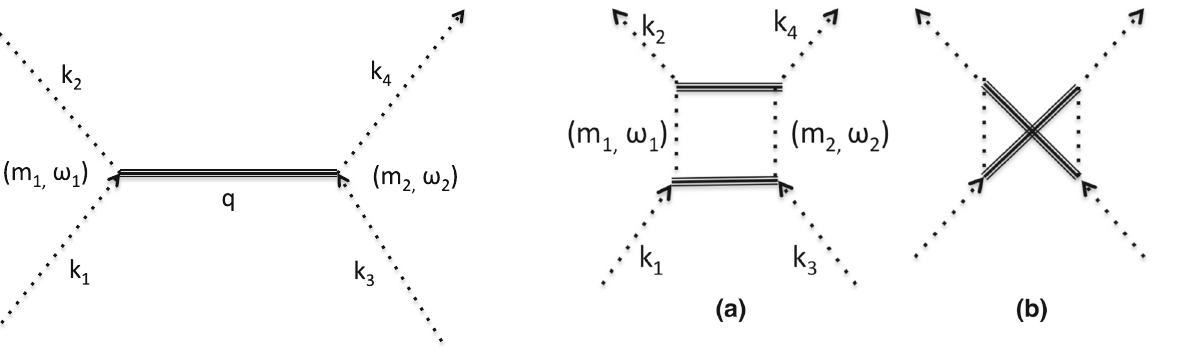
Fig. 2 The set of box ( a ) and crossed-box ( b ) diagrams contribute to the non-analytic components of the